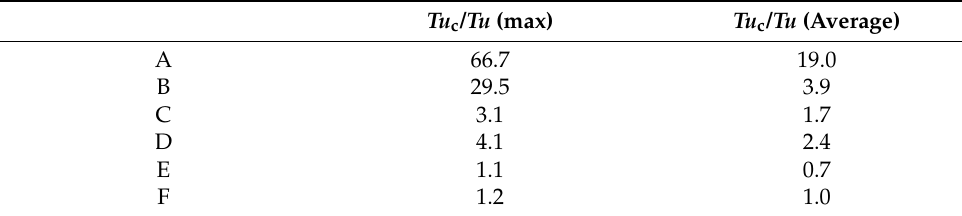
Figure 5. Map of parameters related to the flow regimes A to F evaluated along the jet axis: ( a ) the Tu c / Tu ratio; ( b ) demar- cations of the flow regimes A to F. Table 2. Parameters of the six flow regimes A–F, which were presented in Figure